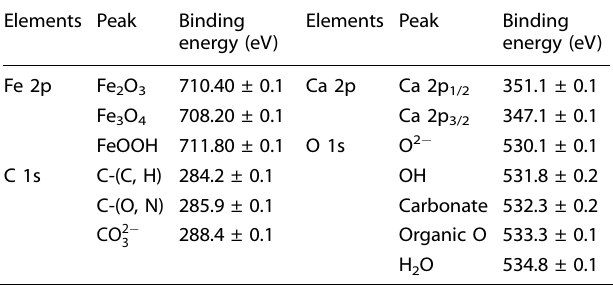
Table 1. Binding energies of elements on the Q235 coupon surface from XPS. Elements Peak